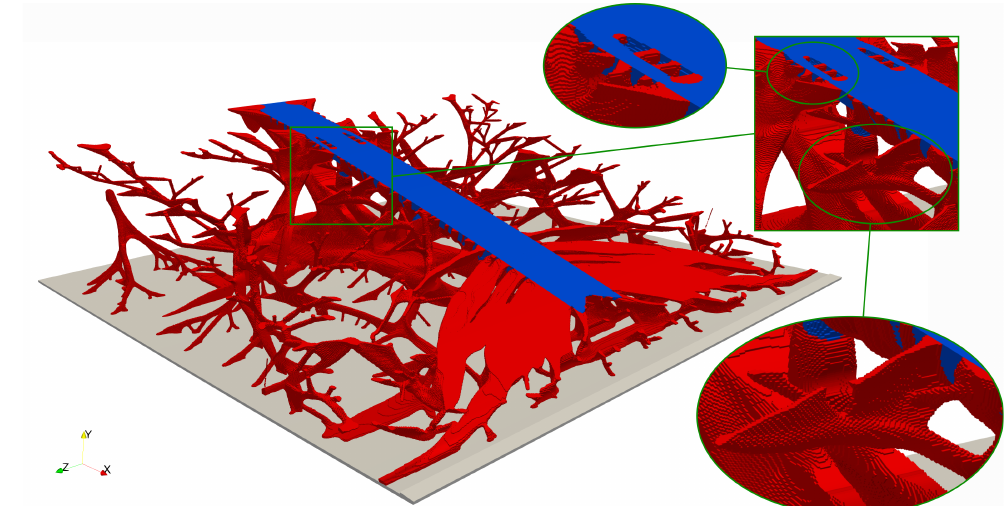
Figure 6. Isometric view of the optimized topology from the density approach with two design domains. The skin on the top side is removed for viewing the internal structure. The field is realized with a threshold value of 0.5. The top close-up shows the structural material forming a composite with the actuating material for optimizing the actuator capabilities. The bottom close-up shows the truss structure merging as thin-plate structure.